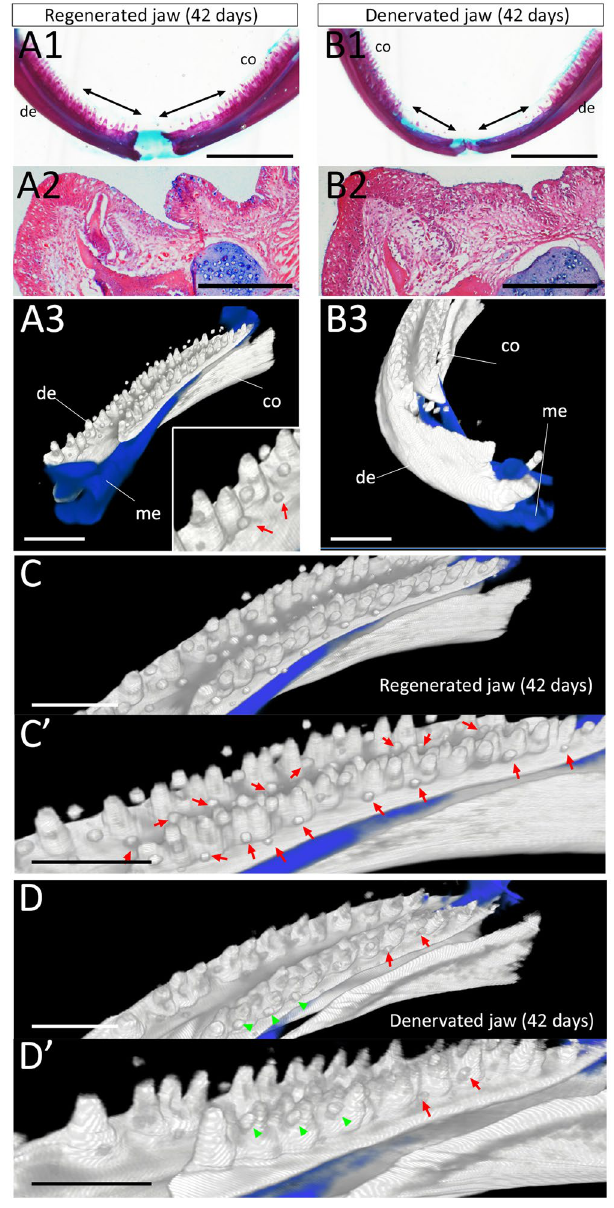
Figure 7. CoMBI imaging of tooth regeneration in innervated and denervated mandibles (42 days after the surgery). (A1, B1) Whole-mount Alcian blue and Alizarin red staining. Arrows in A and B indicate the operated regions. Scale bars are 5 mm. (A2, B2) the section of the regenerated teeth in innervated and denervated mandibles. Scale bars are 500 μ m. (A3, B3) CoMBI images of the regions shown in A1 and B1. The right mandible was processed for CoMBI imaging. Scale bars are 2 mm. ( C ) The proximal (caudal) region of A3. ( C’ ) Reserved tooth buds are obvious in this higher magnification view of C. ( D ) The proximal (caudal) region of B3. ( D’ ) Prevention of the formation of reserve tooth buds is apparent in this higher magnification view of D. Red arrows indicate newly forming tooth buds while green arrows indicate places where tooth bud formation was prevented. co = coronoid. de = dentary. me = Meckel’s cartilage. Scale bars C, C’, D and D’ are 3 mm. Data are representative of n =